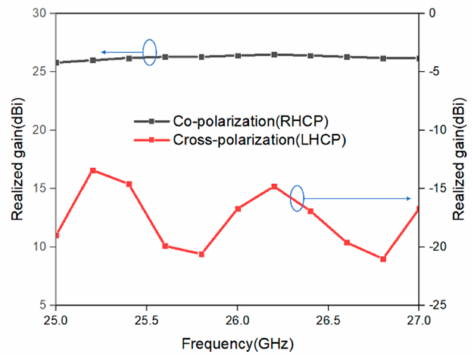
Figure 6. Co-polarization and cross-polarization gains of the transmit array versus